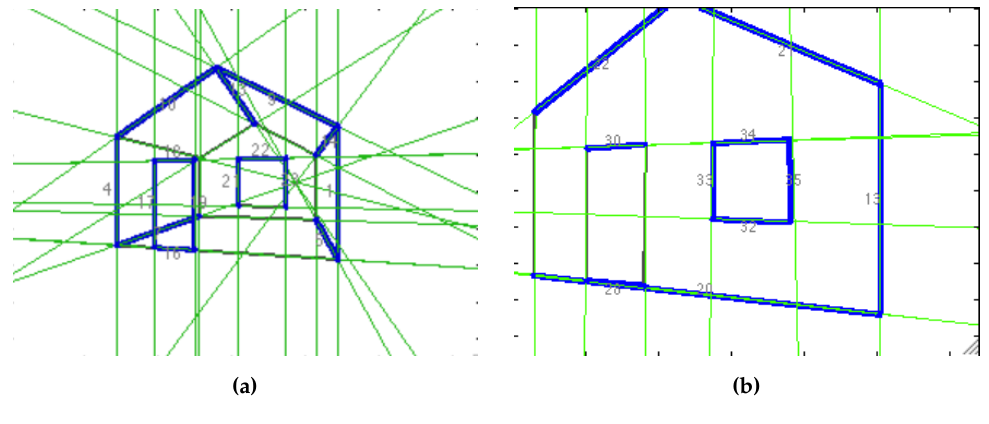
Figure 11. Different visualization modes of objects in the simulation environment. ( a ) Sensor view considering transparent objects; ( b ) sensor view considering opaque